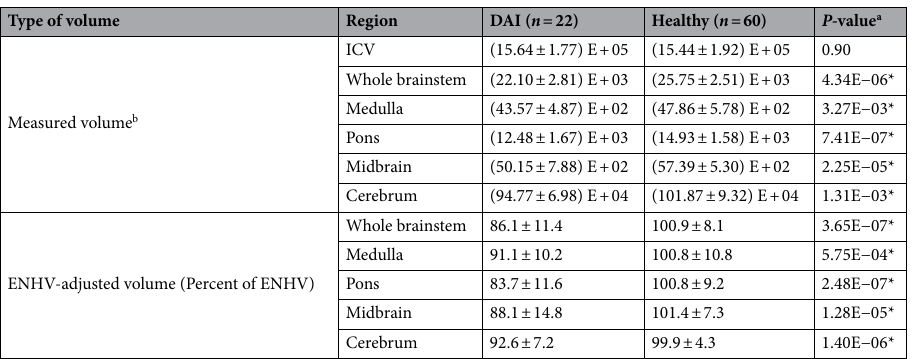
Table 6. ICV and volumes of the five ROIs in DAI patients and healthy controls. a Groups were compared with the Mann–Whitney U test. b The unit of volume is mm 3 . *Significant at P < 0.05 with Bonferroni correction. ICV Intracranial volume, ROI Region of interest, DAI Diffuse axonal injury, ENHV Expected normal healthy